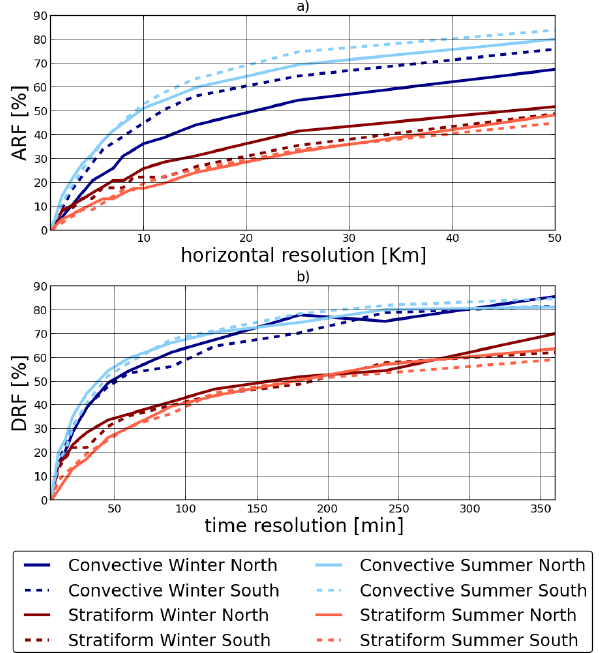
Figure 5. Area and duration reduction factors. (a) Area reduction factors at 5min temporal resolution. (b) Duration reduction factors (DRFs) for 1km × 1km spatial resolution in percent for convective (blue) and stratiform (red) precipitation. Data shown for the summer and winter seasons and northern and southern Germany.